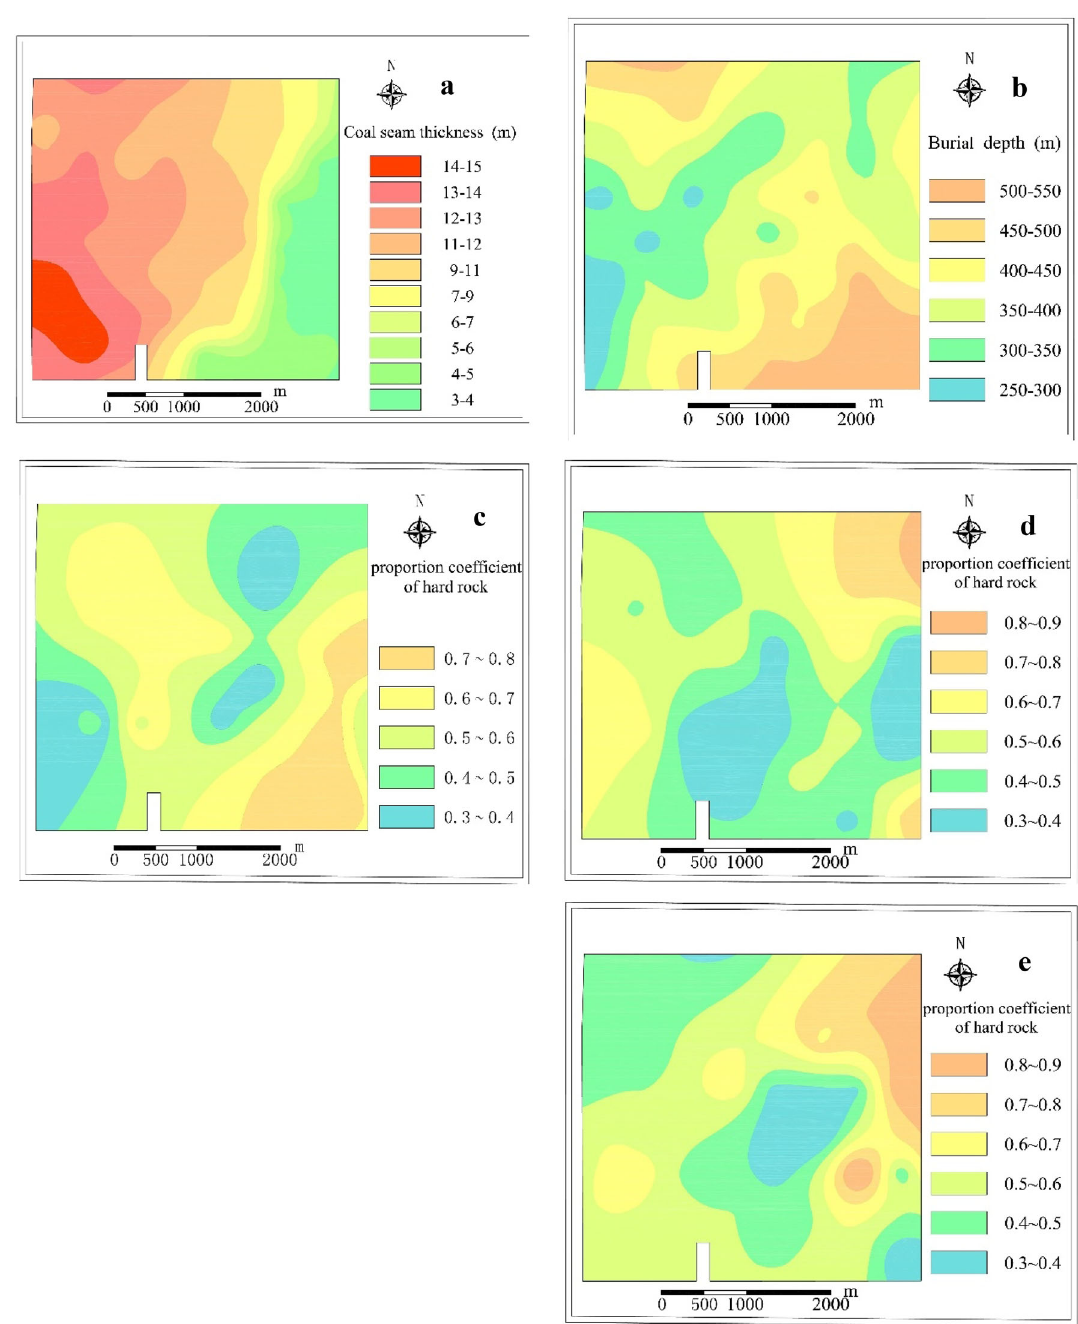
Fig. 8 Thematic maps of main control factors of the water-flowing fracture zone